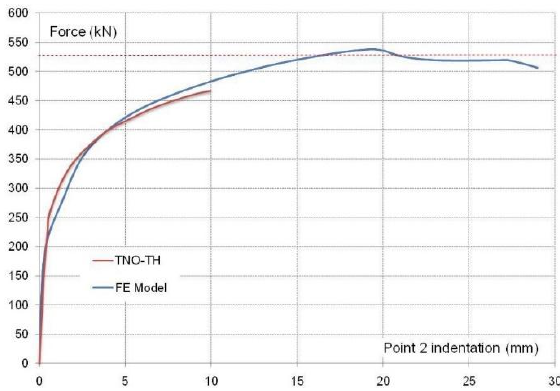
Figure 7. Curve compression force vs . indentation at point 2.